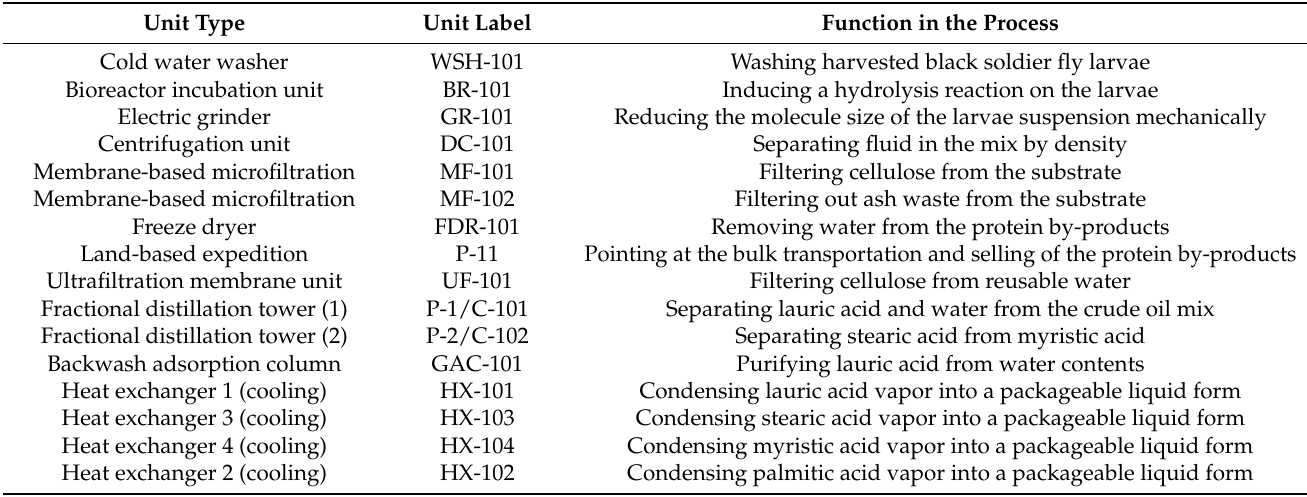
Table 3. The unit processes involved in the plant.